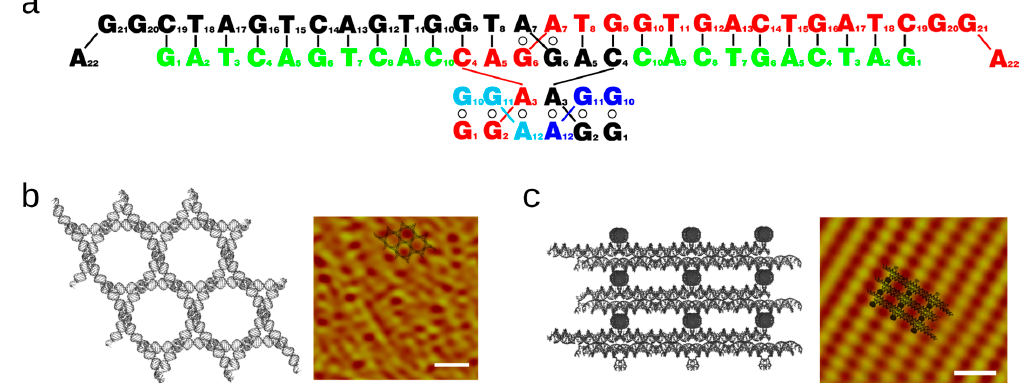
Figure 7. The expanded non-canonical lattice. ( a ) Secondary structure of the expanded lattice. Green “spacer” strands are required to pair with the 10 or 11 nucleotide expansion; ( b , c ) Models of the expanded solvent channels parallel and perpendicular to the six-fold symmetry axis, respectively. AFM images confirmed the presence of the solvent channels and unit cell dimensions, along with low resolution diffraction [65]. Scale bars are 20 nm.